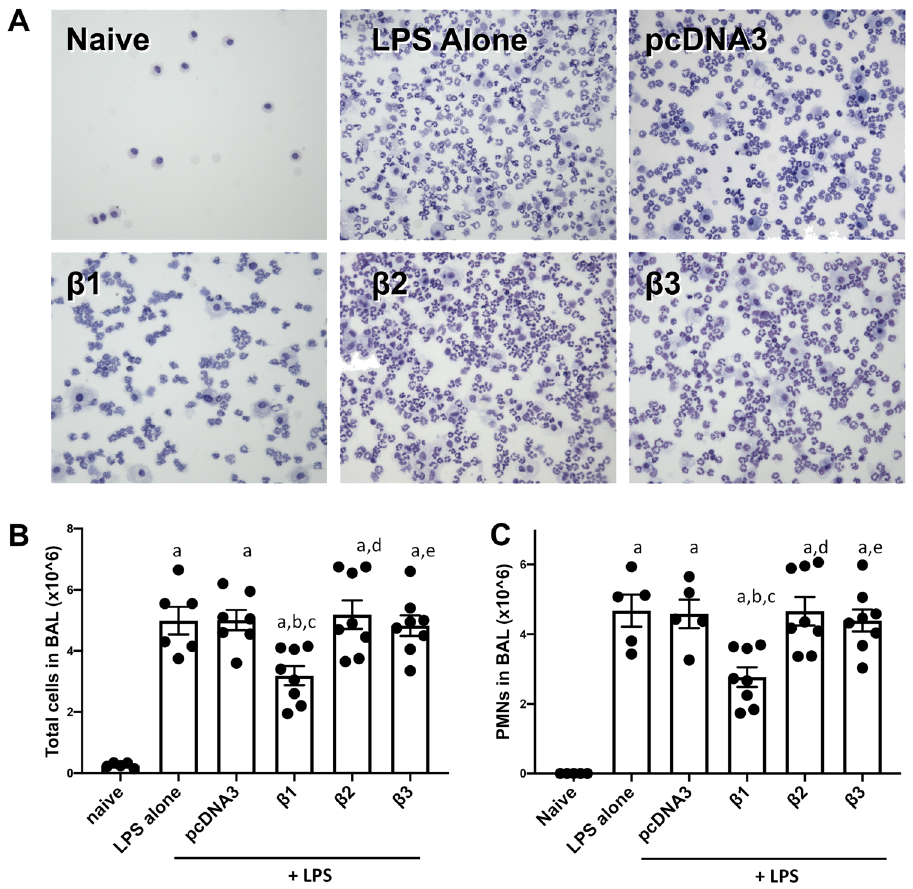
Figure 2. Electroporation mediated gene delivery of the β1, but not the β2 or β3 subunits, of the Na + ,K + - ATPase attenuates inflammation in LPS injured lungs. Lung injury was established in C57B6 mice (n = 6–8) by aspiration of LPS (5 mg/kg) and 1 day later plasmids (100 μg each) expressing either no insert (pcDNA3), or the β1, β2, or β3 subunits of the Na + ,K + -ATPase (β1, β2, or β3) were delivered in 50 μl to the lungs by aspiration followed immediately by electroporation (8 pulses of 10 ms duration each and 200 V/cm). Naïve mice (n = 5) received no LPS or DNA. Two days after gene transfer (3 days after LPS administration), lungs were lavaged with PBS and BAL fluid was collected and analyzed for cellularity by cytospin followed by Diff-quik staining ( A ). All experiments were carried out three times and a representative experiment is shown. Total cells were quantified in the BAL fluid and shown as mean ± SEM ( B ). One-way ANOVA with post-hoc Tukey’s multiple comparisons was used for statistical analysis; a, p < 0.0001 compared to naïve; b, p < 0.05 compared to LPS alone; c, p < 0.05 compared to LPS + pcDNA3; d, p < 0.01 compared to LPS + β1; e, p < 0.05 compared to LPS + β1. The number of PMNs in the BAL fluid were also quantified and shown as mean ± SEM ( C ). One-way ANOVA with post-hoc Tukey’s multiple comparisons was used for statistical analysis; a, p < 0.0001 compared to naïve; b, p < 0.01 compared to LPS alone; c, p < 0.05 compared to LPS + pcDNA3; d, p < 0.01 compared to LPS + β1; e, p < 0.05 compared to LPS +